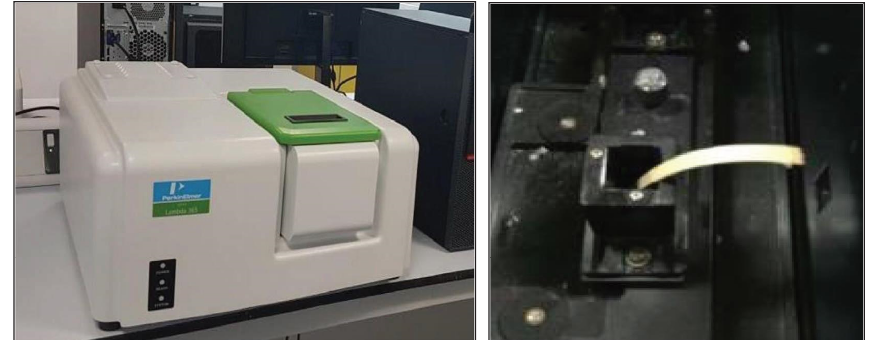
Figure 2: Te specimen was centered in front of the xenon lamp in the center of a spectrophotometer’s tube (Perkin Elmer,